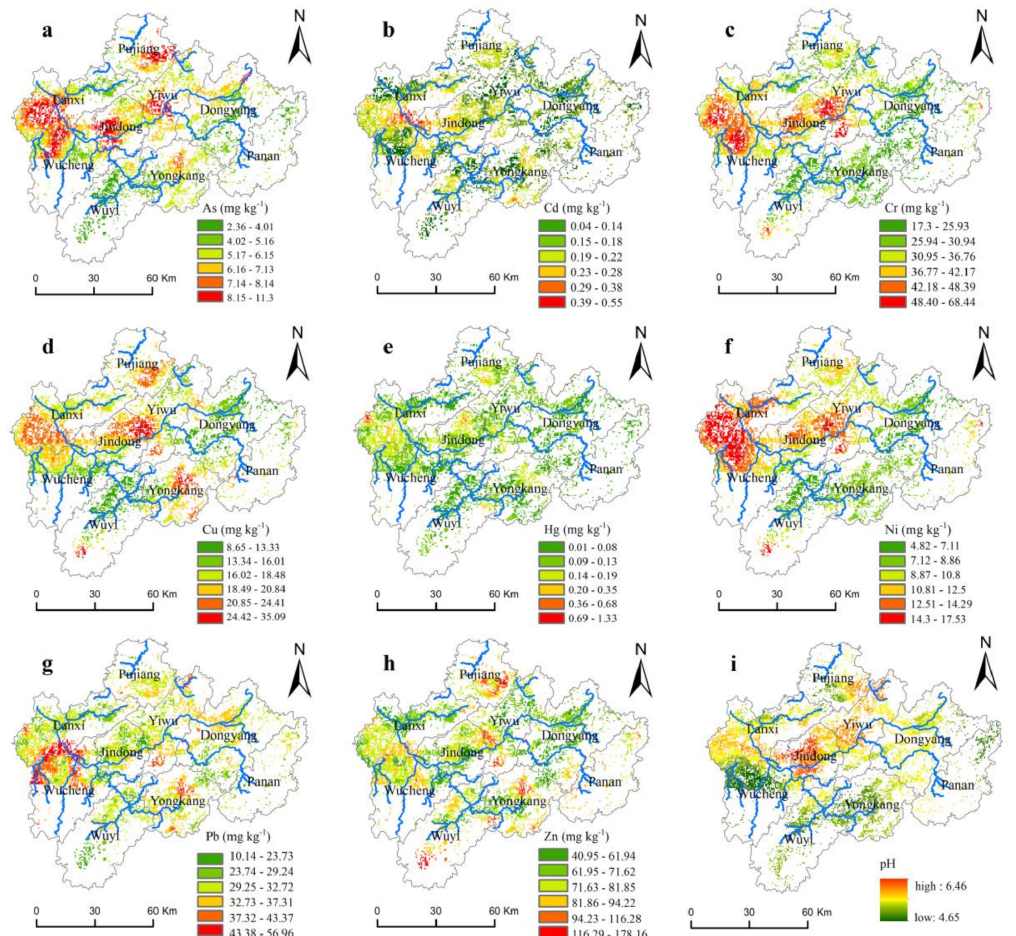
Figure 3. Spatial distribution of soil heavy metals (( a ): As, ( b ): Cd, ( c ): Cr, ( d ): Cu, ( e ): Hg, ( f ): Ni, ( g ): Pb, ( h ): Zn, ( i ): pH) concentration in the agricultural land of Jinhua